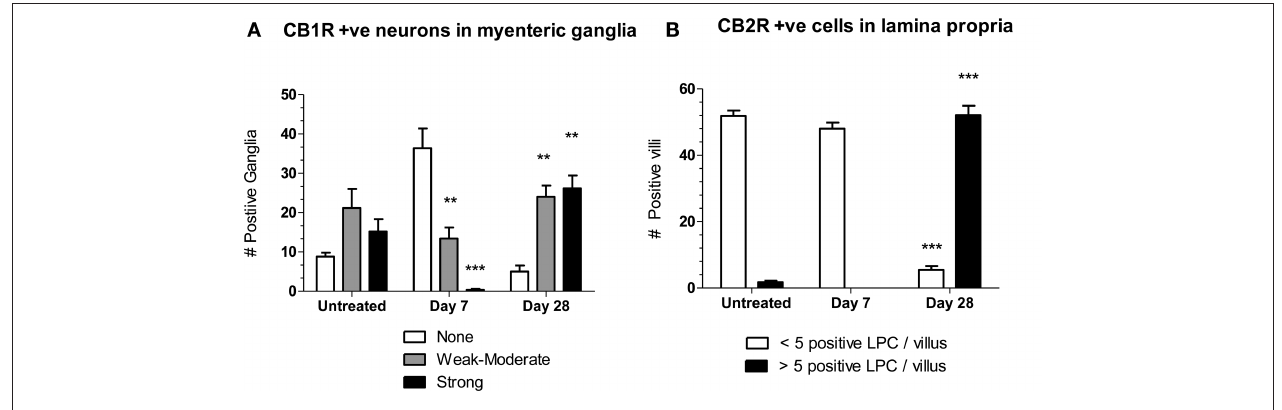
Figure 2 | (A) The number of myenteric ganglia in jejunoileal tissue with moderate (gray bars) and intense (black bars) CB1R-stained neurons are decreased at day 7 and increased at day 28 compared to untreated tissue. Changes in the number of ganglia in which CB1R staining was absent (clear bars) were not significantly different in post-OM compared to untreated tissue.